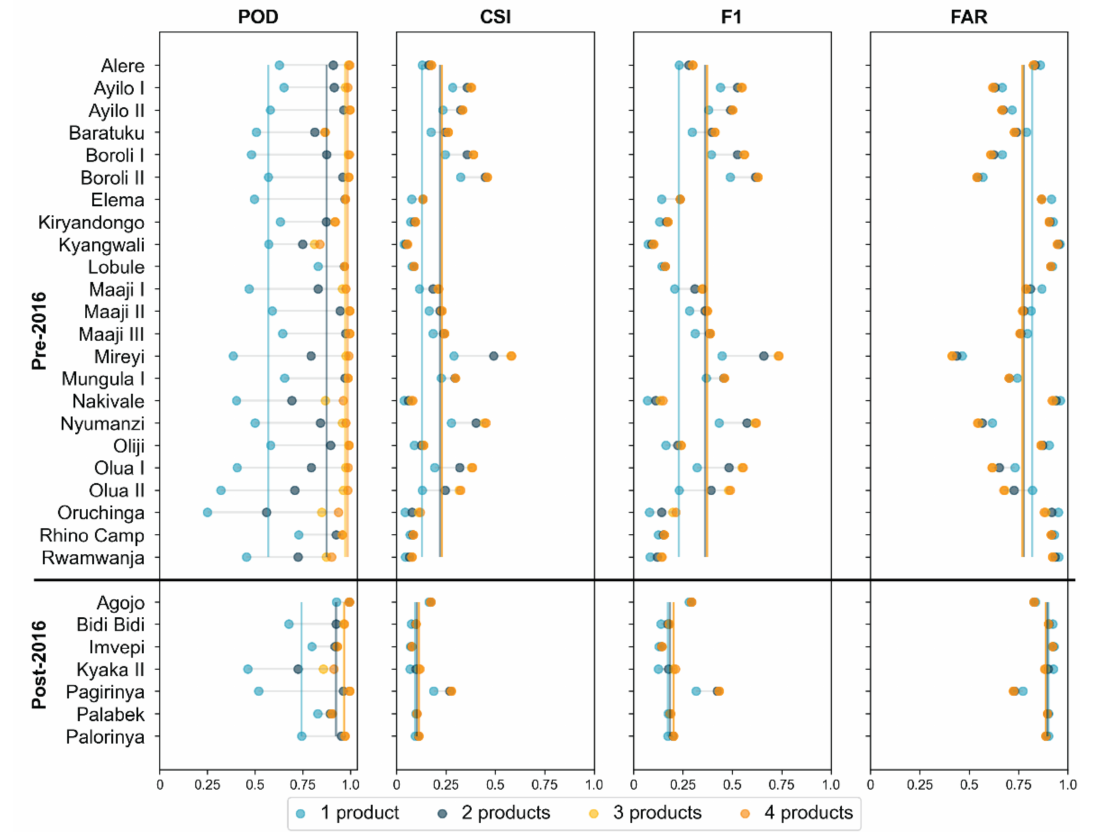
Figure A4. Lollipop plots of probability of detection (POD), critical success index (CSI), F1-score (F1) and false alarm rate (FAR) for multi-product agreement sites in comparison to OSM–MS building footprint coverage across all refugee settlements: “1 product” indicates unique coverage by a single product; “2 products”, “3 products” and “4 products” indicate the number of settlement products that share coverage. POD, probability of detection; CSI, critical success index; F1, F1-score; FAR, false alarm